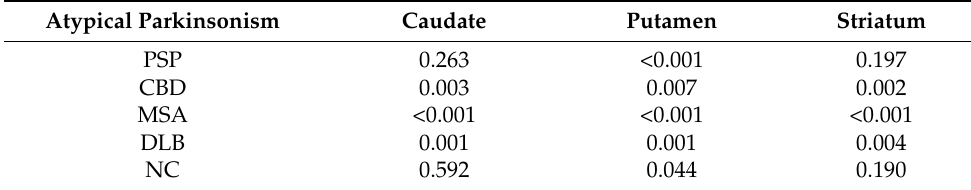
Table 5. Hemispherical differences in atypical parkinsonisms ( p -values). Atypical Parkinsonism